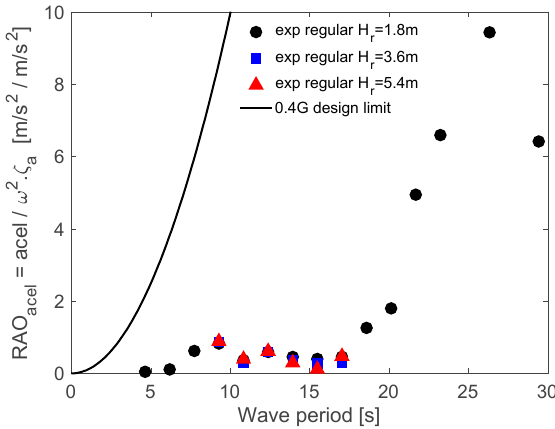
Figure 13. Experimental RAO acceleration results at the turbine nacelle.